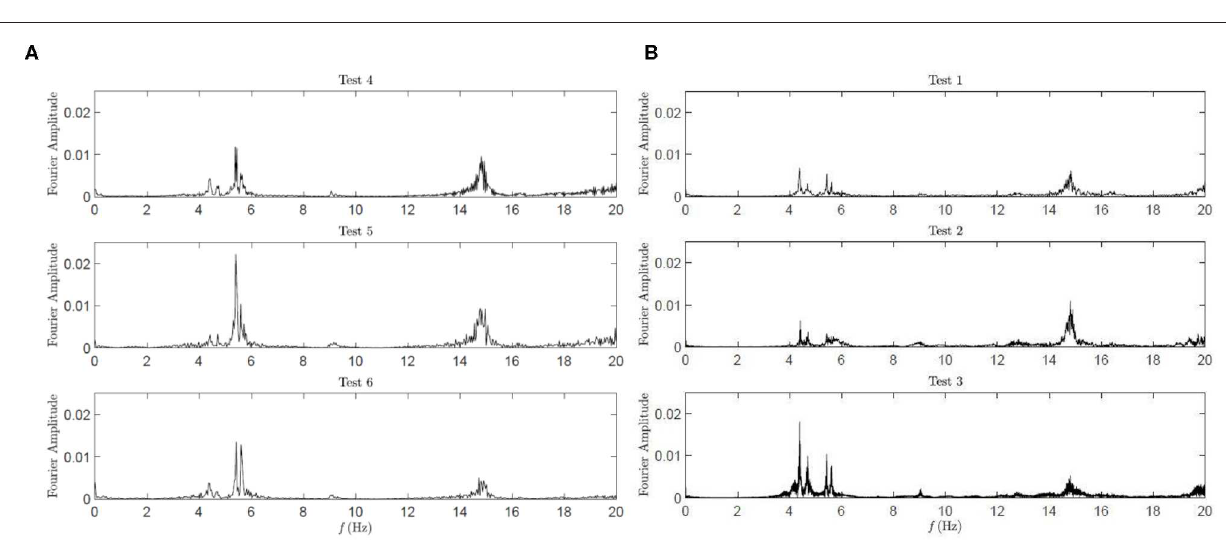
are tabulated in Table 1 . The duration of each test was between 30 s to 5 min. Tests 4, 5, and 6 include the free vibration response recorded during jumping of a single subject near the center of the